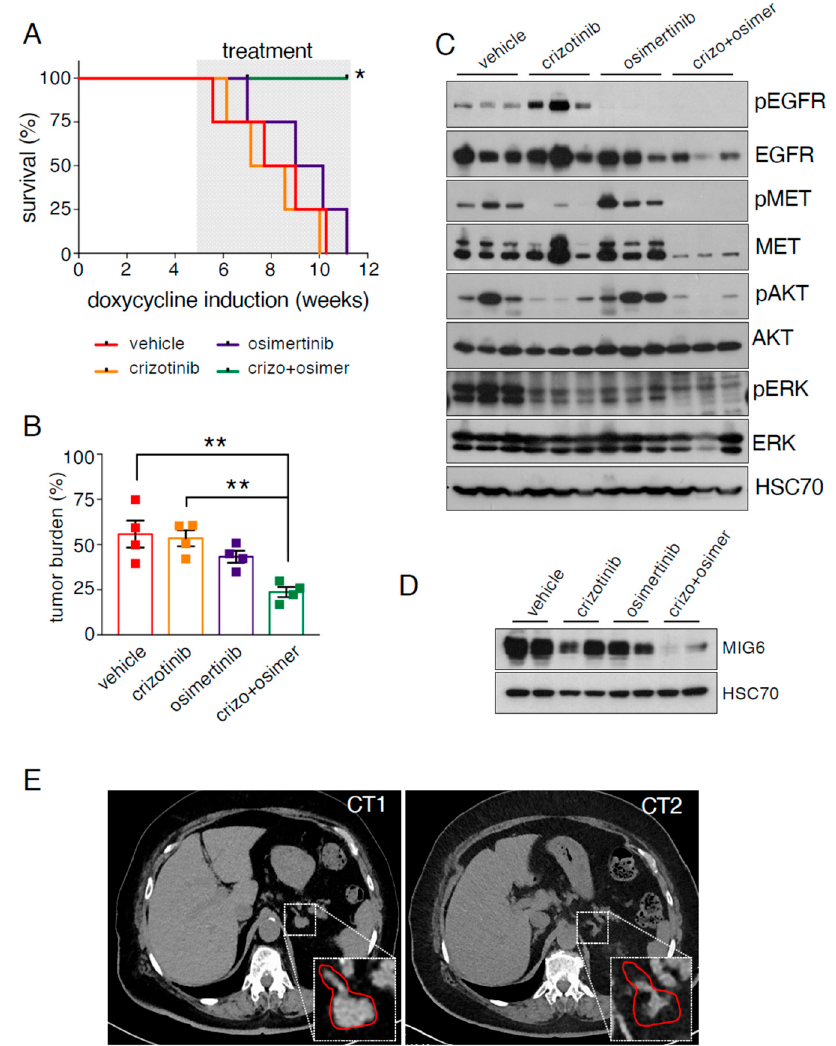
Figure 4. EGFR/MET-driven tumors are sensitive to the osimertinib and crizotinib combination. ( A ) Kaplan–Meier plot showing the survival rate of EGFR/MET mice treated with vehicle, crizotinib and/or osimertinib ( n = 4 mice/group) for 6 weeks. The x axis shows the time since tumor induction by doxycycline; * p ≤ 0.05 (Mantel–Cox test) ( B ) Tumor burden from the mice described in ( A ) ( n = 4 animals per treatment group). Data are the mean ± SEM; ** p ≤ 0.01 (one-way ANOVA followed by Tukey post hoc test). ( C ) Immunoblotting of the indicated proteins in lung protein extracts from the same mice described in ( A ). ( D ) Immunoblotting of the indicated proteins in lung protein extracts from the same mice described in ( A ). ( E ) CT scan of a patient presenting EGFR del19 mutation and MET amplification upon relapse after osimertinib single treatment (CT1) and 3 months after osimer- tinib and crizotinib treatment started (CT2). Magnification of the tumoral area is presented and highlighted in red.